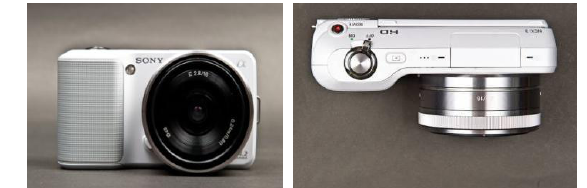
Figure 3. The adopted digital cameras (Sony Nex-3) for our prototype of PPIMS.